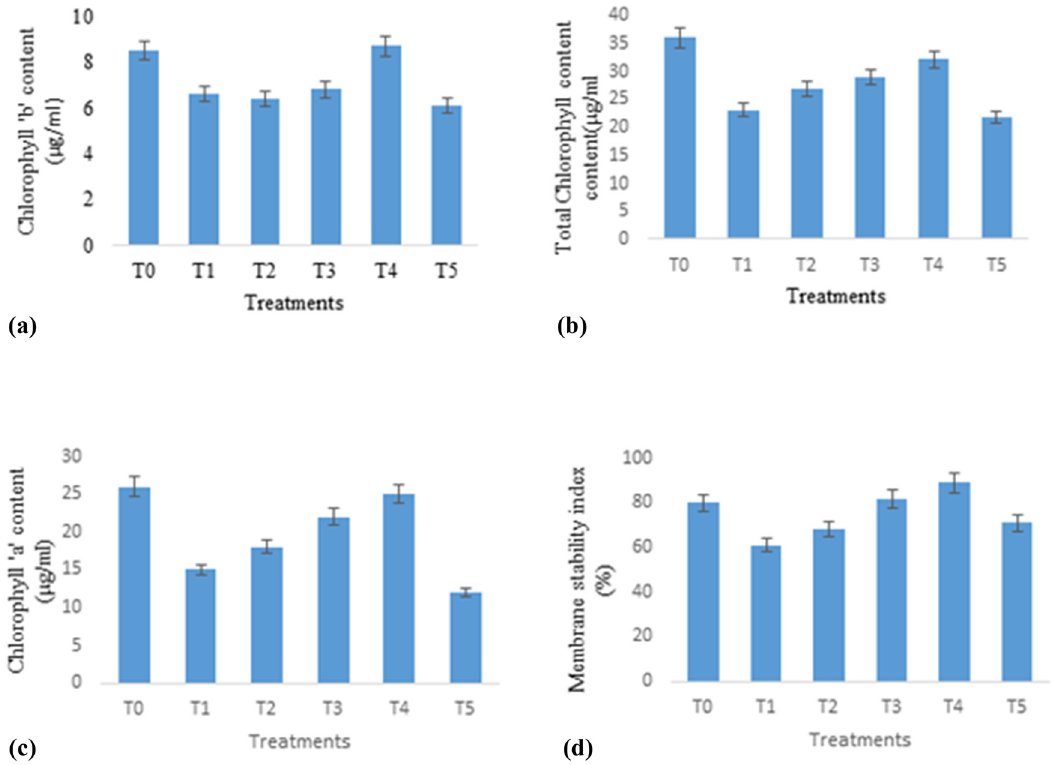
Figure 10: Physiological parameters: ( a ) chlorophyll b content, ( b ) total chlorophyll content, ( c ) chlorophyll a content ( d ) , and MSI of wheat plants under P. striiformis stress in response to various concentrations of AgNPs: 25, 50, 75, and 100 mg · L − 1 . The data is presented as the mean ± S.D from three independent biological replicates. The error term is mean square error = p ≤